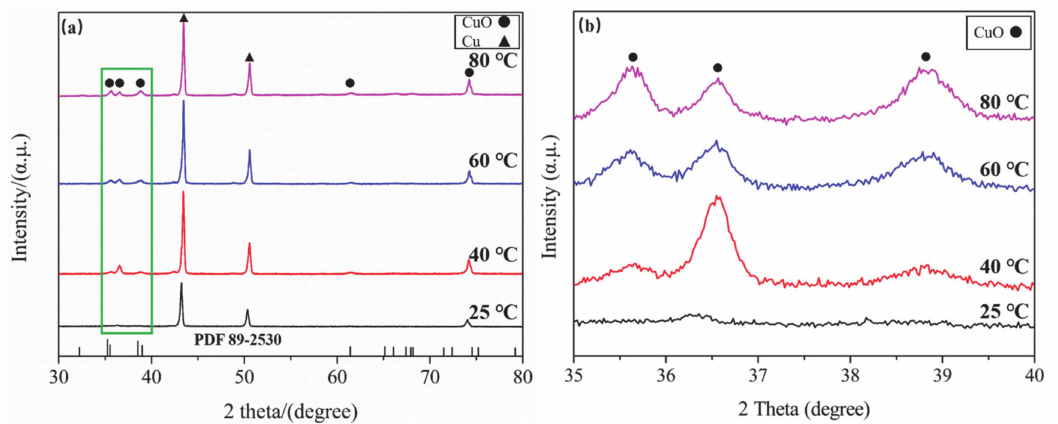
Figure 3. The XRD spectrum of CuO / Cu foam prepared with di ff erent anodizing temperature ( a ) and partial enlarged view ( b ).